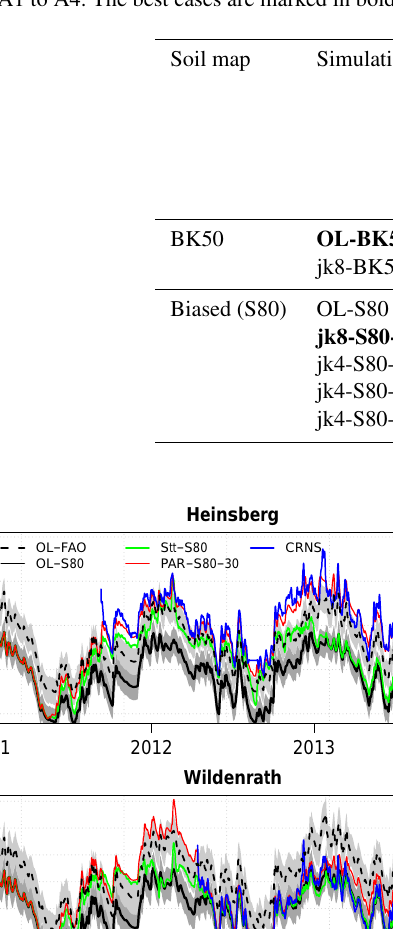
Table 4. Root mean square error ( E RMS , cm 3 cm − 3 ) and mean absolute bias (cm 3 cm − 3 ) for open loop (OL- ∗ ), jackknife simulations with eight CRNSs (simulations jk8-S80-1 to 9 were averaged) and with four CRNSs (simulations jk4-S80-A to C). Results were averaged over the omitted sites only. Data at omitted sites were not assimilated, while at the other sites data were assimilated. At sites where data were assimilated, E RMS and bias were equal to the values found in simulation PAR-S80-30. Site-specific errors and biases are provided in the Appendix A1 to A4. The best cases are marked in bold.